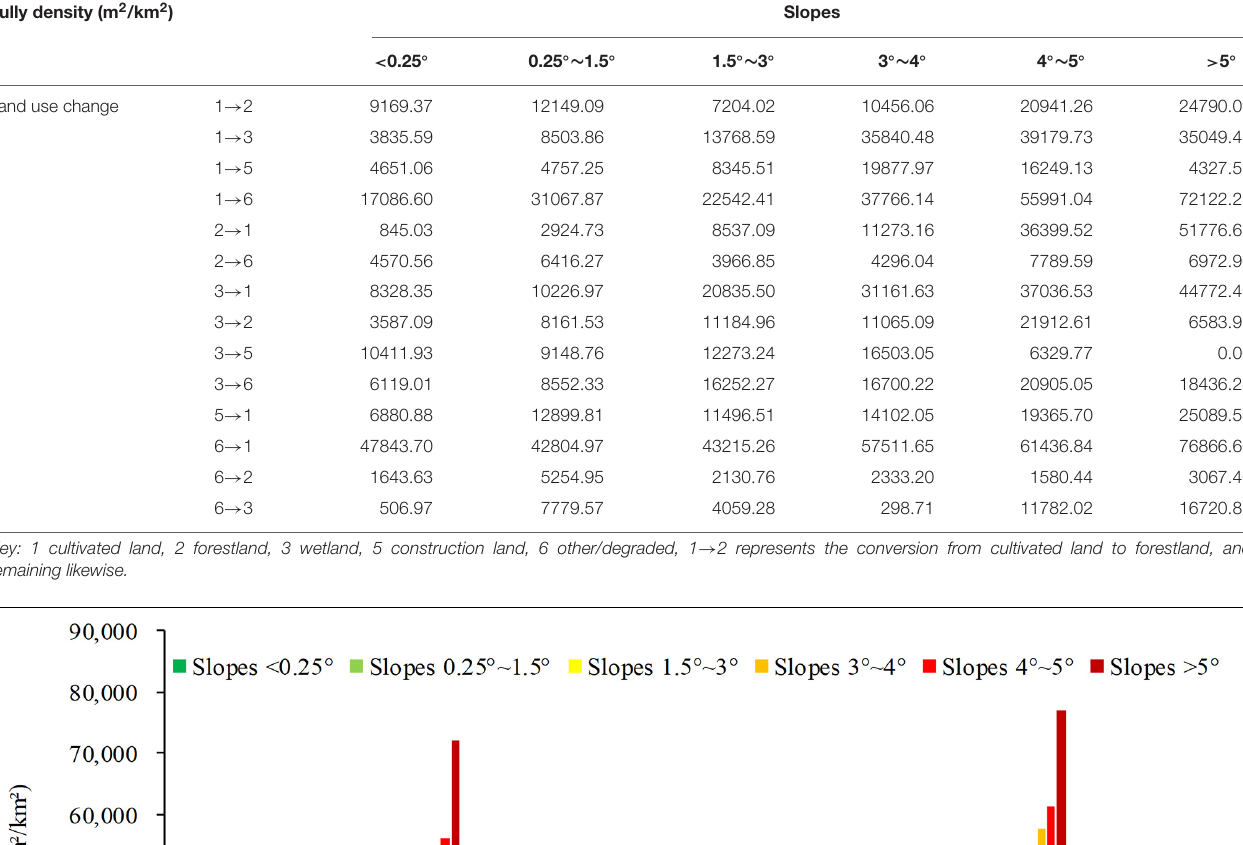
TABLE 5 | Change of gully erosion density caused by conversion of land use under different slopes from 1965 to 2015. Gully density (m 2 /km 2 )